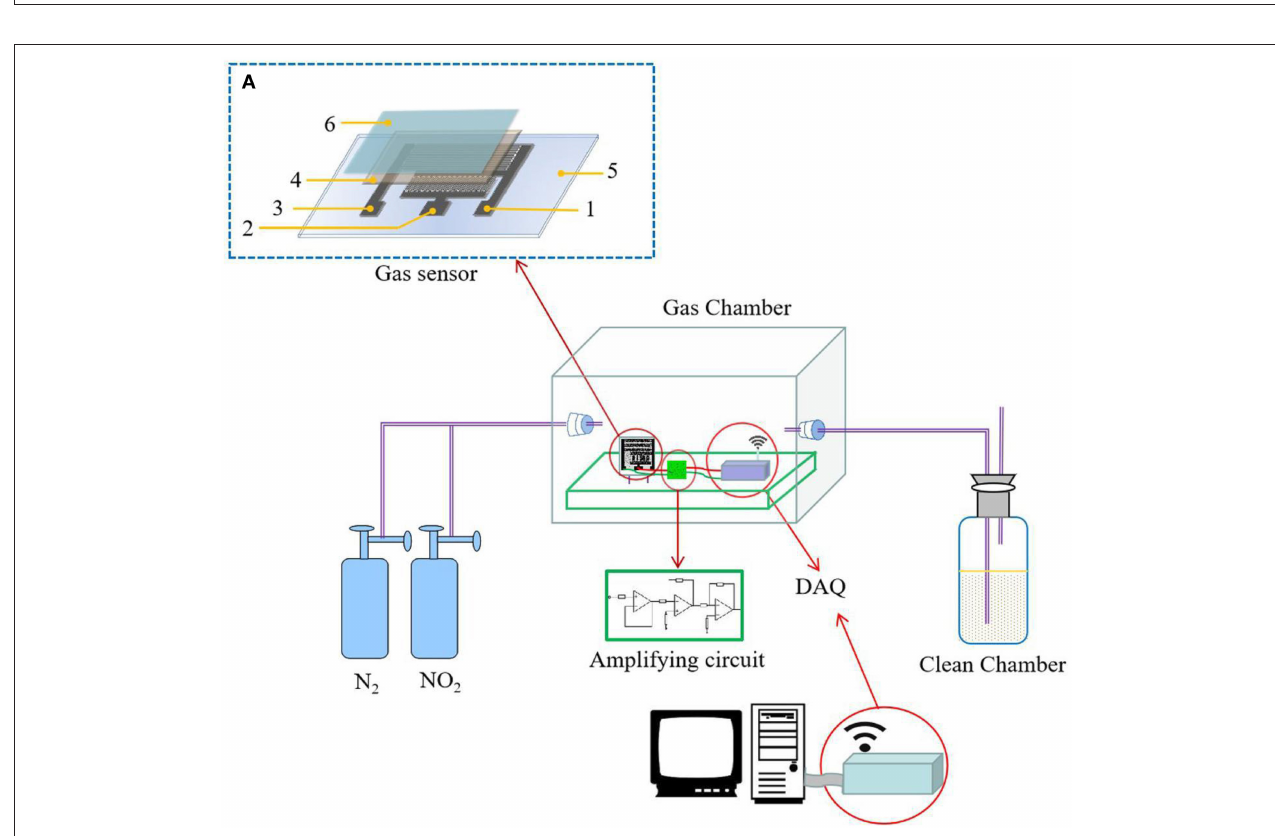
corresponds to the carbon bonded in -CF 2 - (Chakradhar et al., 2014). The sample doped with CNTs is C = C bond at 284.3